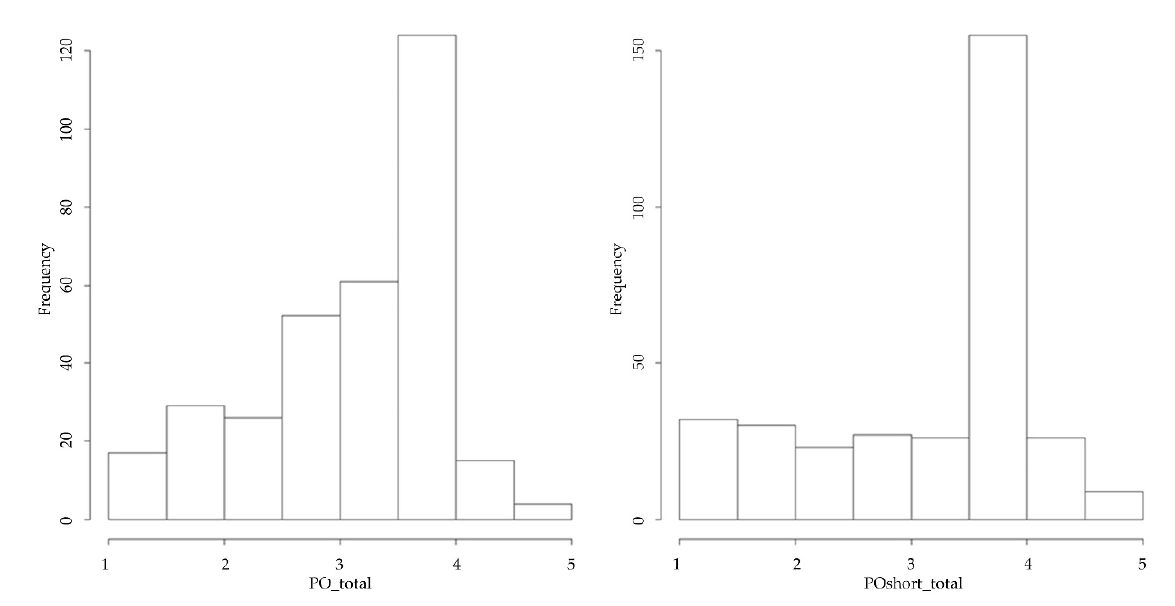
Figure 5. Histogram of original scale (left) and shortened scale (right) at measurement time point 1. Note. Correlation of the two scales is r = 0.84. Abbreviations: PO_total = original seven-item scale measuring psychological ownership; POshort_total = shortened 4-item scale measuring psy- chological ownership.